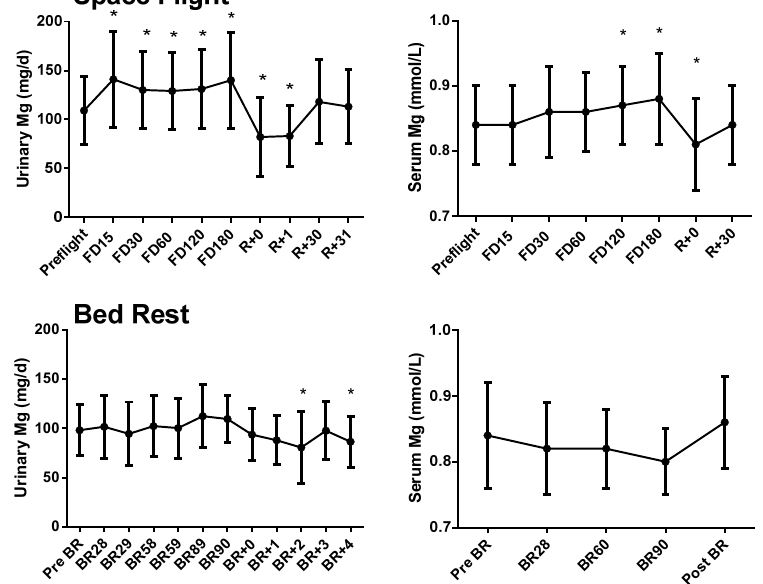
Figure 1. Urinary ( n = 43) and serum ( n = 39) magnesium before, during (flight days 15, 30, 60, 120, and 180), and after space flight (0, 1, 30, and 31 days after landing) (upper panels), and before, during, and after bed rest (lower panels, n = 27 urine and serum). Circles and error bars represent mean and SD respectively. * Significantly different from preflight mean ( p < 0.05). For bed rest serum magnesium data, there was a significant effect of time ( p < 0.05), but the post hoc Bonferroni test did not identify any individual group differences compared to baseline.